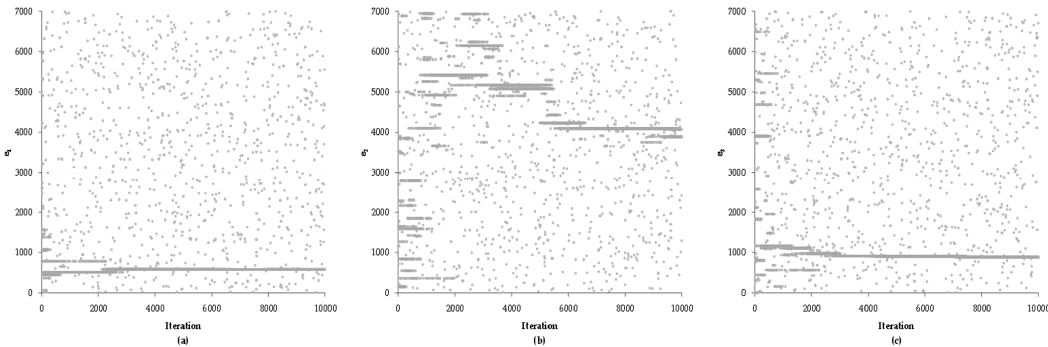
Figure 8. Behavior of the scale parameters for the EV1-3P with respect to the iterations of ( a ) λ 1 ; ( b ) λ 2 ; and ( c ) λ 3 for hydrometric station 10040.